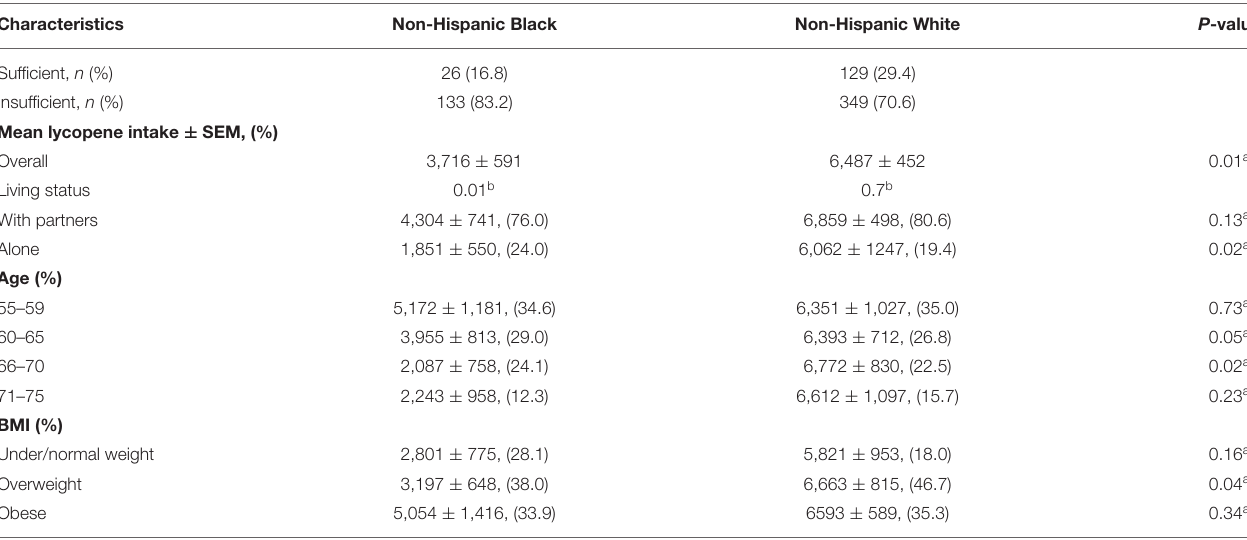
TABLE 4 | Non-Hispanic Black individuals consume less lycopene than Non-Hispanic White individuals.